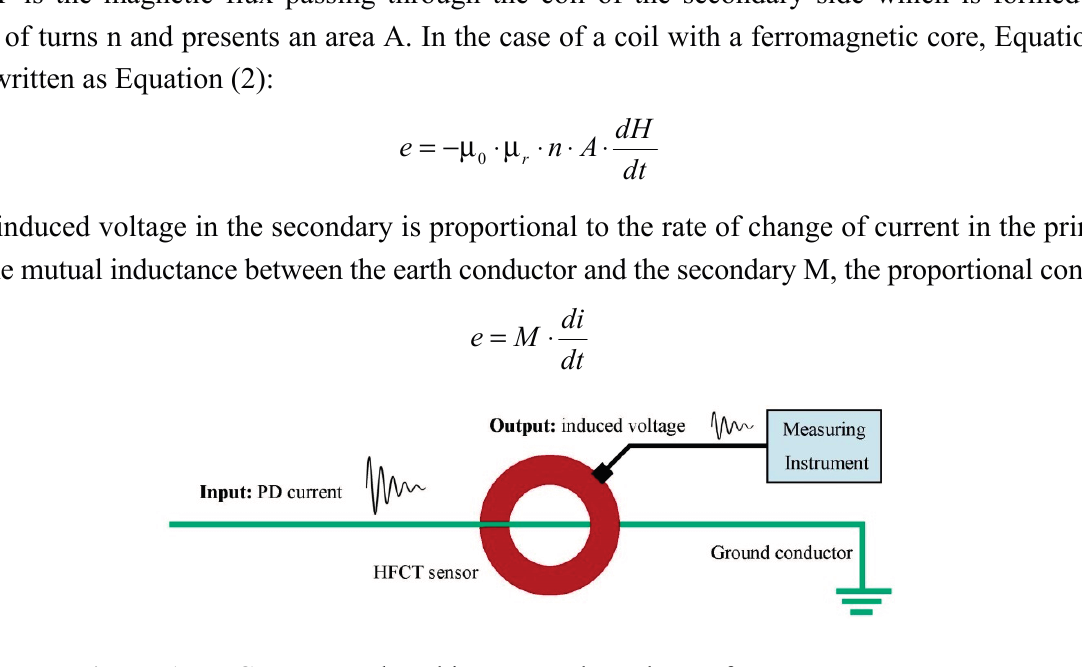
Figure 1. HFCT sensor placed in a ground conductor for PD